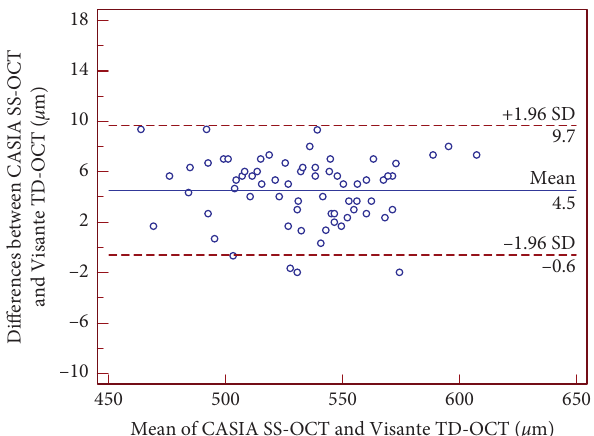
Figure 1: Bland–Altman plot showing the agreement for CCT measurements between the CASIA SS-OCT and the Visante TD- OCT. The solid line indicates the mean difference (bias), and the dotted lines indicate 95% limits of agreement (LoA).